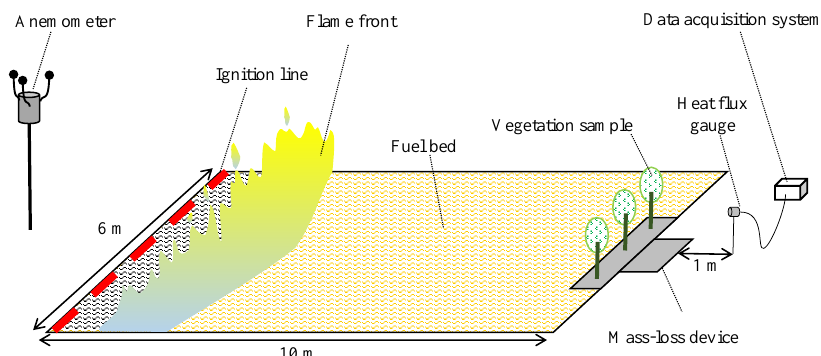
Figure 3. Experimental